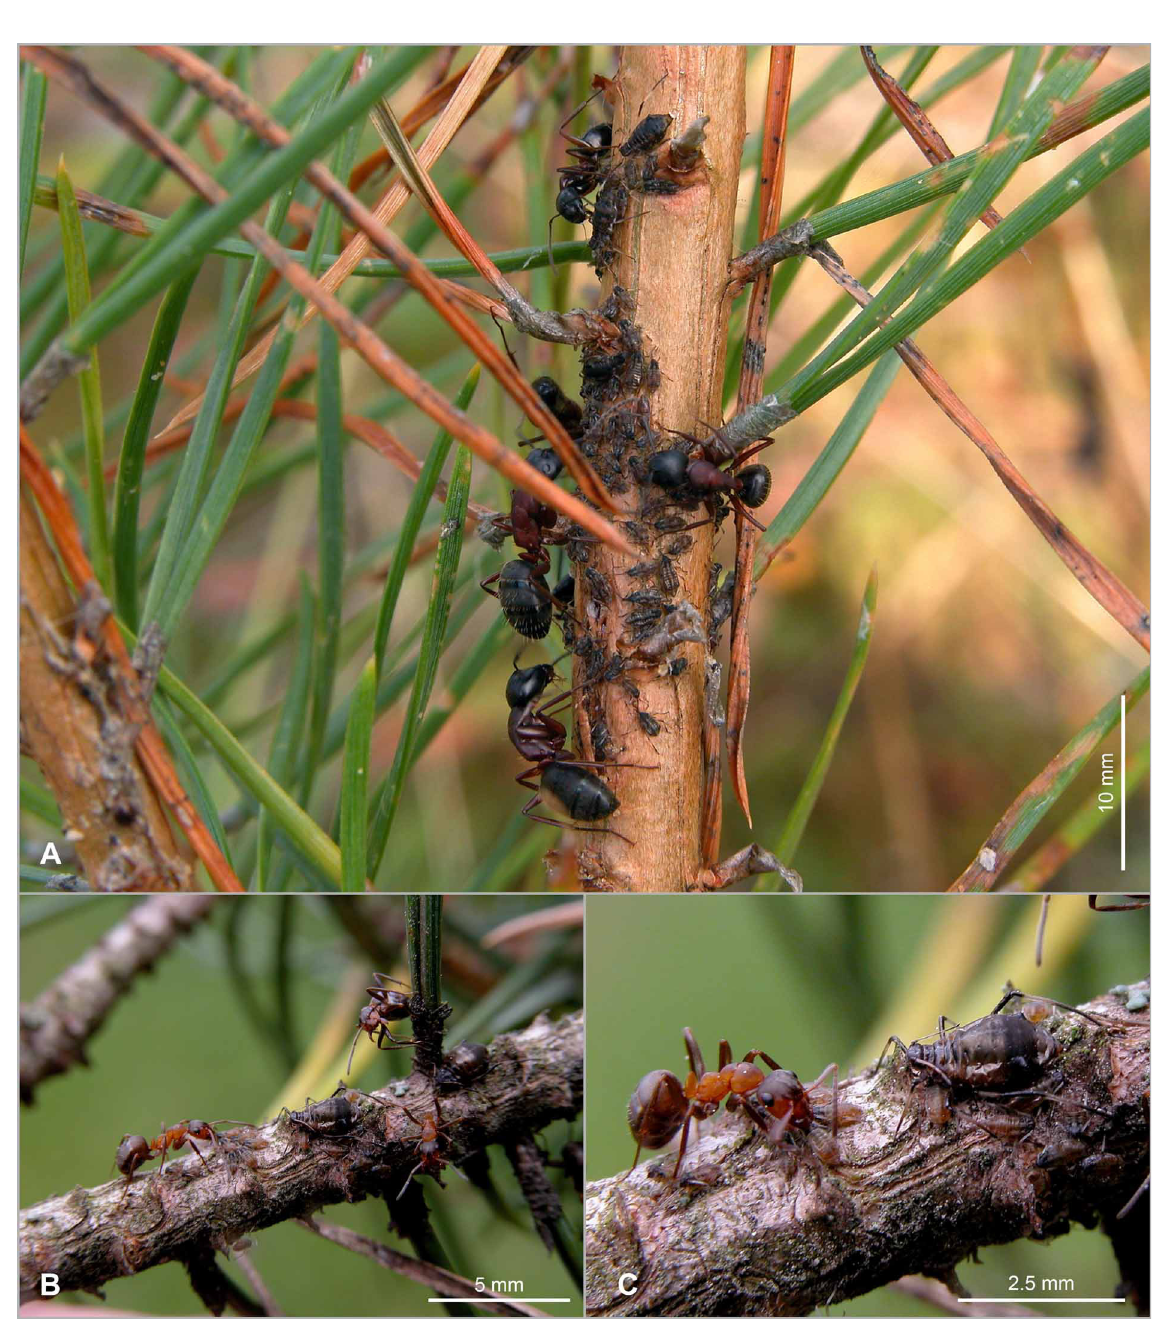
Fig. 88. Cinara (Cinara) pini (Linnaeus, 1758) on Pinus sylvestris . A . Colony on previous year’s terminal shoot, attended by Camponotus herculeanus (Linnaeus, 1758). B–C . Apterae with young on a 2 year-old twig, attended by Formica polyctena Förster,